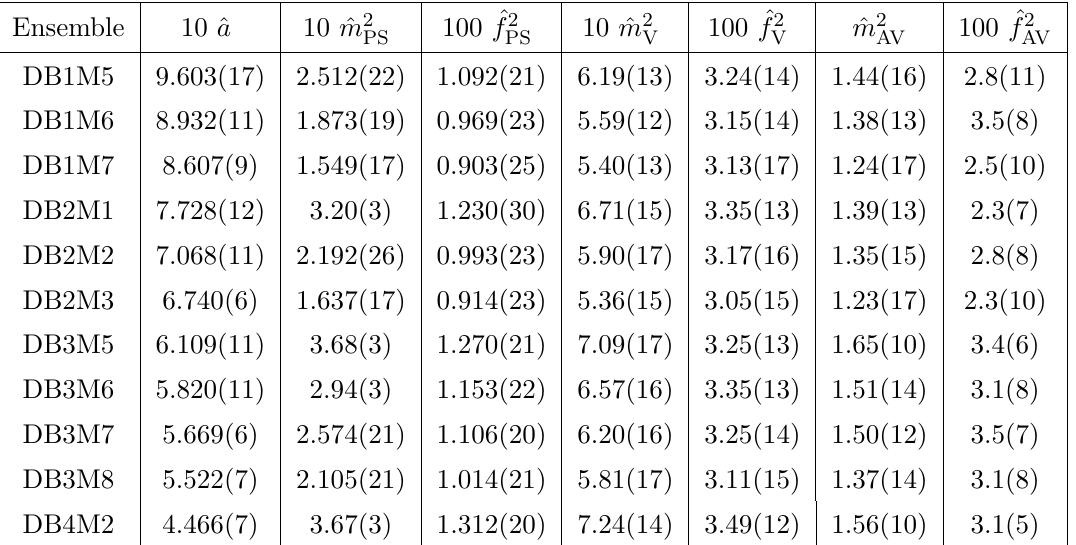
Table 9. Input data used in the continuum EFT global (cid:12)t. We consider only ensembles with ^ a . 1 . 0 : 4. For each ensemble, we subtracted the (cid:12)nite lattice spacing e(cid:11)ect, according to and ^ m 2 PS eqs. (4.13) and (4.14), with the coe(cid:14)cients W 0